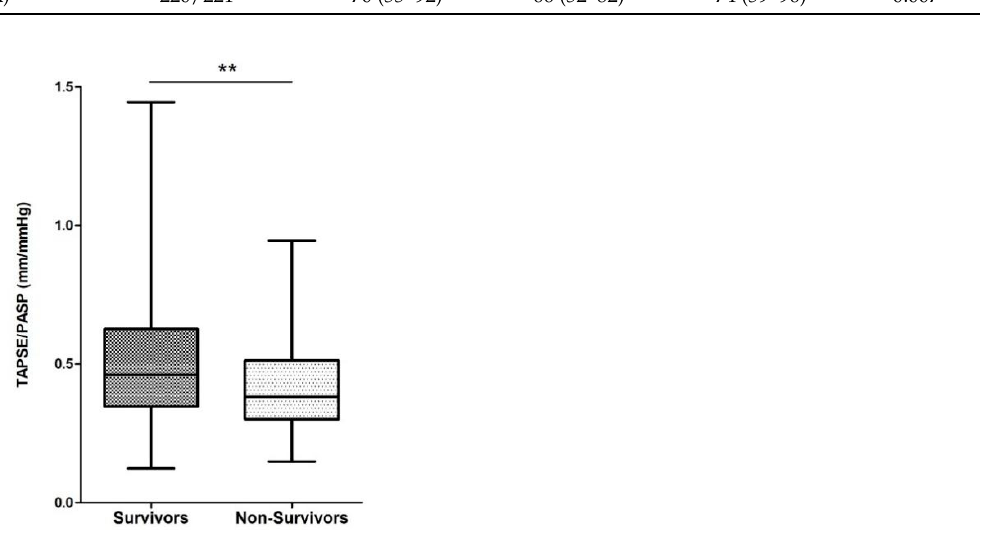
Figure 4. Receiver-operating characteristics curve showing the predictive power of TAPSE/PASP and TAPSE for ( A ) RVEF